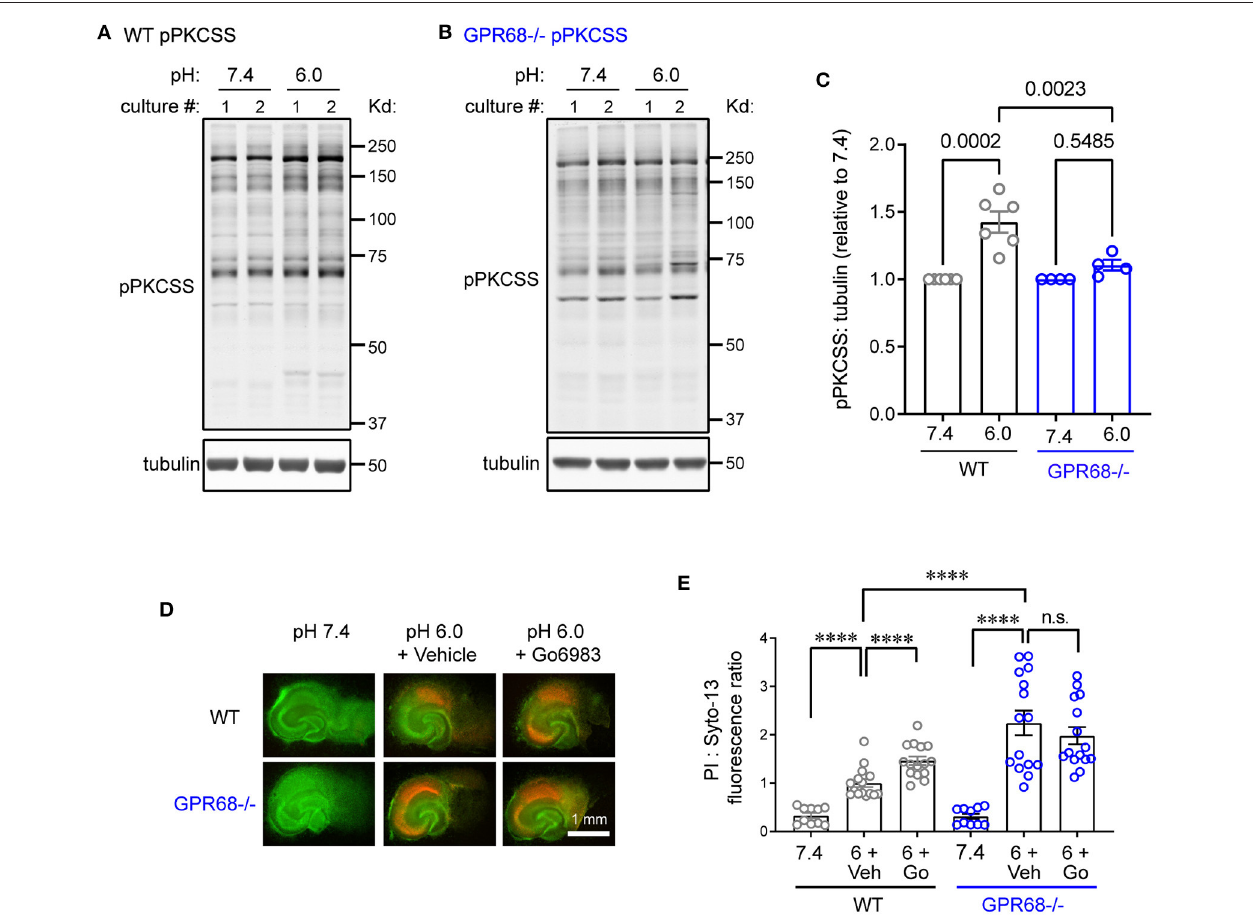
FIGURE 2 | PKC inhibition on acidosis-induced neuronal injury. (A–C) Representative Western blot and quantification of 1-h pH 6-induced phosphorylation of PKC substrates (pPKCSS) in WT and GPR68 − / − hippocampal slices. As described in Methods, for phosphorylation, each animal (pup) generated one culture. The pH 6-treated group was normalized to the 7.4 control in the same culture (generated from the same animal). Each dot on the summary plot thus represents results obtained from one culture, which was generated from one animal. In Western blot analysis, for motif antibodies, we quantified the total number of pixels for the entire lane. (D,E) Representative fluorescence images (D) and quantification (E) of pH 6.0-induced neuronal injuries in organotypic hippocampal slices. Slices were treated for 2-h with pH 7.4 (control) or pH 6.0 in the presence of 0.05% DMSO (vehicle) or 5 µ M Go6983. Neuronal injury was analyzed as described in Figure 1 . As described in Methods, for survival analysis, each culture used slices isolated from multiple animals (pups). The slices were randomly plated in culture inserts and each slice was imaged separately. Each culture generates 5–6 slices per condition. Summary plot were pooled data from 3 separate experiments, with each dot represents one individual slice. P -values were from 2-way ANOVA with Tukey’s correction. ****p <